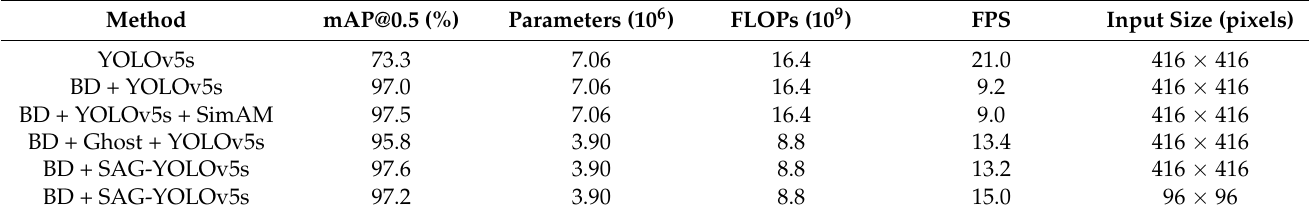
Table 1. Ablation